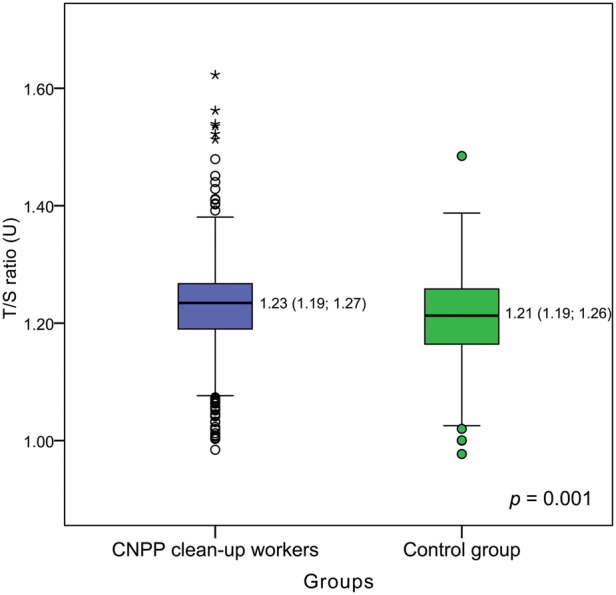
Boxplots of relative telomere length (T/S ratio) in Chernobyl accident recovery workers and the gender- and age-matched control group (median value and interquartile range are shown; circles indicate outliers, asterisks indicate extreme outliers).